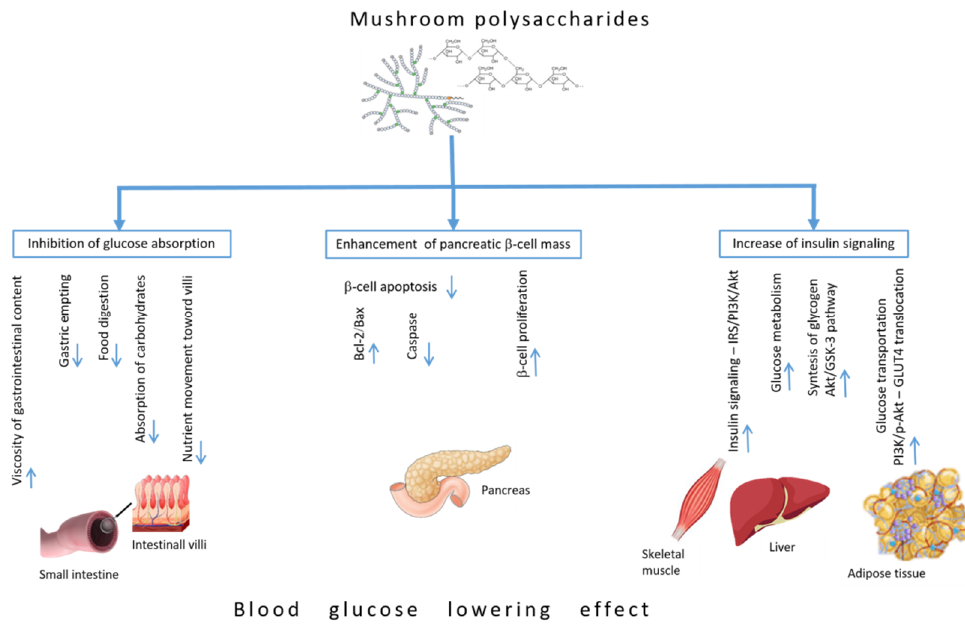
Figure 2. Anti-hyperglycemic mechanisms of mushroom polysaccharides in different tissues in- volved in glucose homeostasis. IRS: Insulin receptor substrate; PI3K: Phosphoinositide 3-kinase; AKT: Serine/threonine-specific protein kinase; GSK-3: Glycogen synthase kinase-3; GLUT4: Glucose transporter-4.